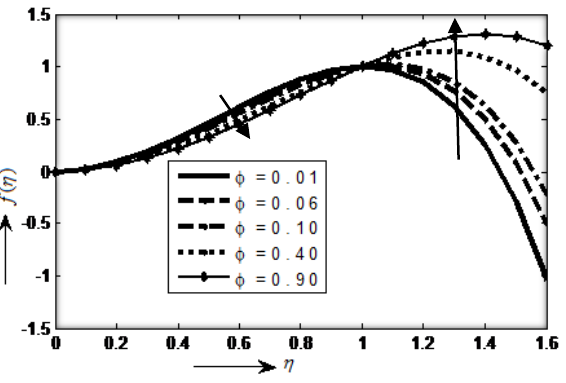
Figure 14. Variation of fluid velocity f (  ) against  for slip coefficients  (0.01, 0.06, 0.10, 0.40, 0.90) by taking parameters M =0, K = 0 and Re =